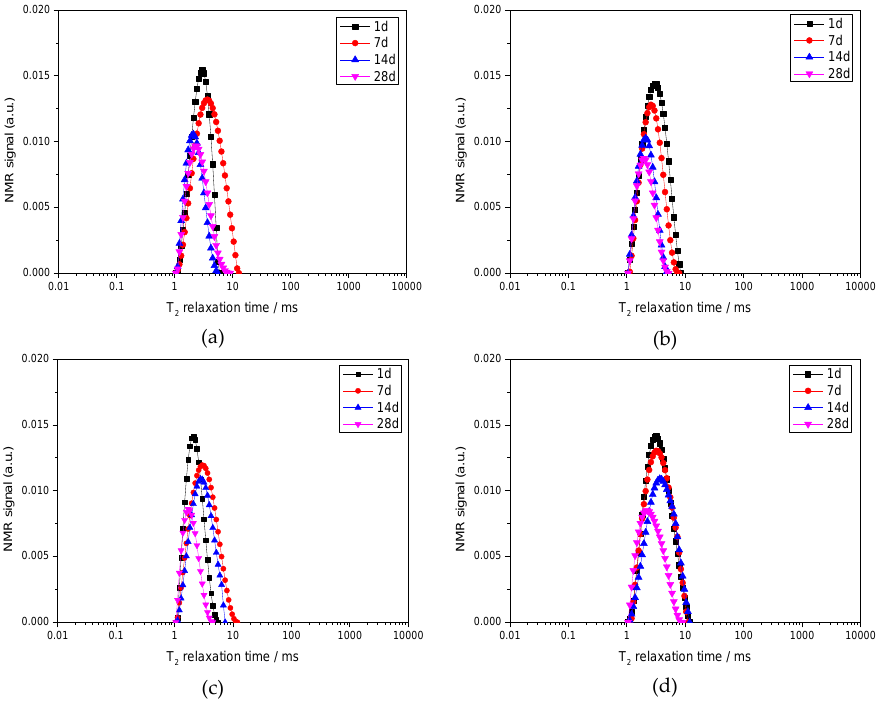
Figure 8. The long-duration T 2 relaxation time of CPB mixture with different hydration time when the polynaphtalene sulfonate dosage is: ( a ) 0, ( b ) 0.2%, ( c ) 0.4%, and ( d ) 0.8%.